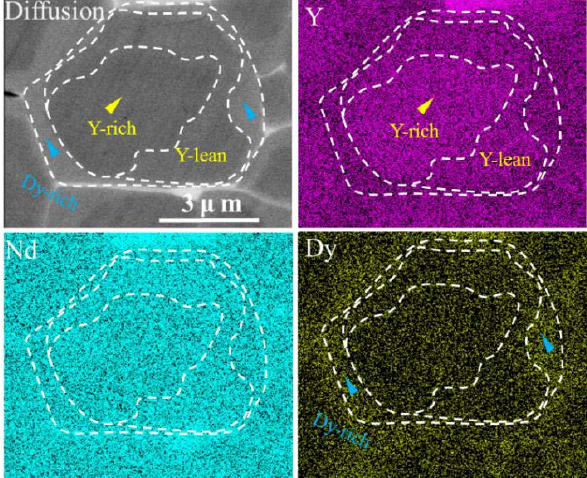
Figure 5. Back-scattered SEM image mappings for the DyH x diffusion magnet at the depth of 50 μ m.